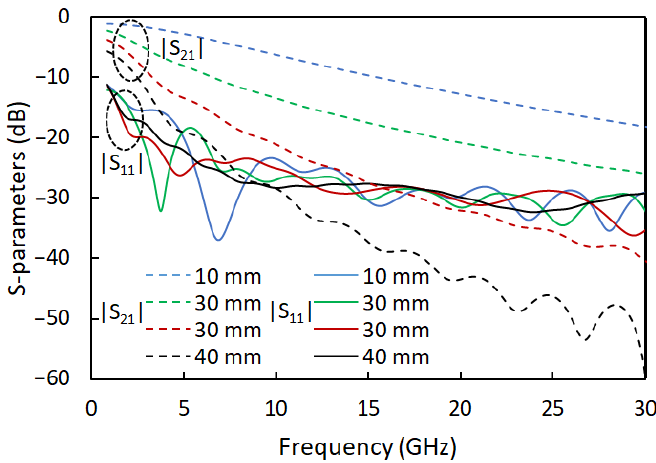
Figure 4. The S-parameters of the laser-scribed terminations with a series of rGO lengths l in two-port configurations.